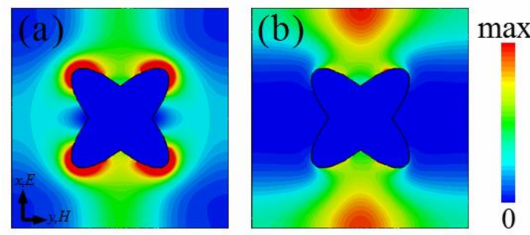
Figure 4. The loss density distributions of the x – y plane on the CCOSG surface: ( a ) f 1 = 1.34 THz and ( b ) f 2 = 1.71 THz, respectively ( µ c = 0.5 eV).